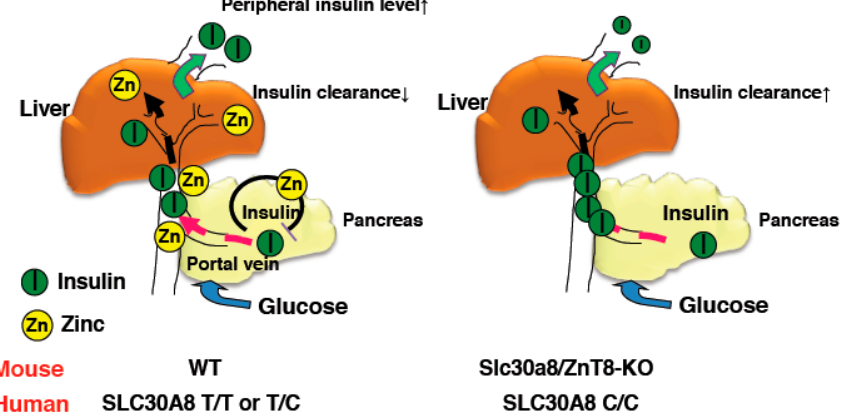
Figure 1. Schematic representation of insulin clearance in WT and ZnT8-KO mice. Zinc co-secreted with insulin suppresses insulin secretion from pancreatic β cells and inhibits hepatic insulin clearance in WT mice ( left ). In contrast, reduced zinc secretion results in enhanced insulin secretion from β cells in ZnT8-KO mice and hepatic insulin clearance is not suppressed ( right ). Thus, peripheral insulin levels in ZnT8-KO mice are maintained at lower levels than in WT mice.